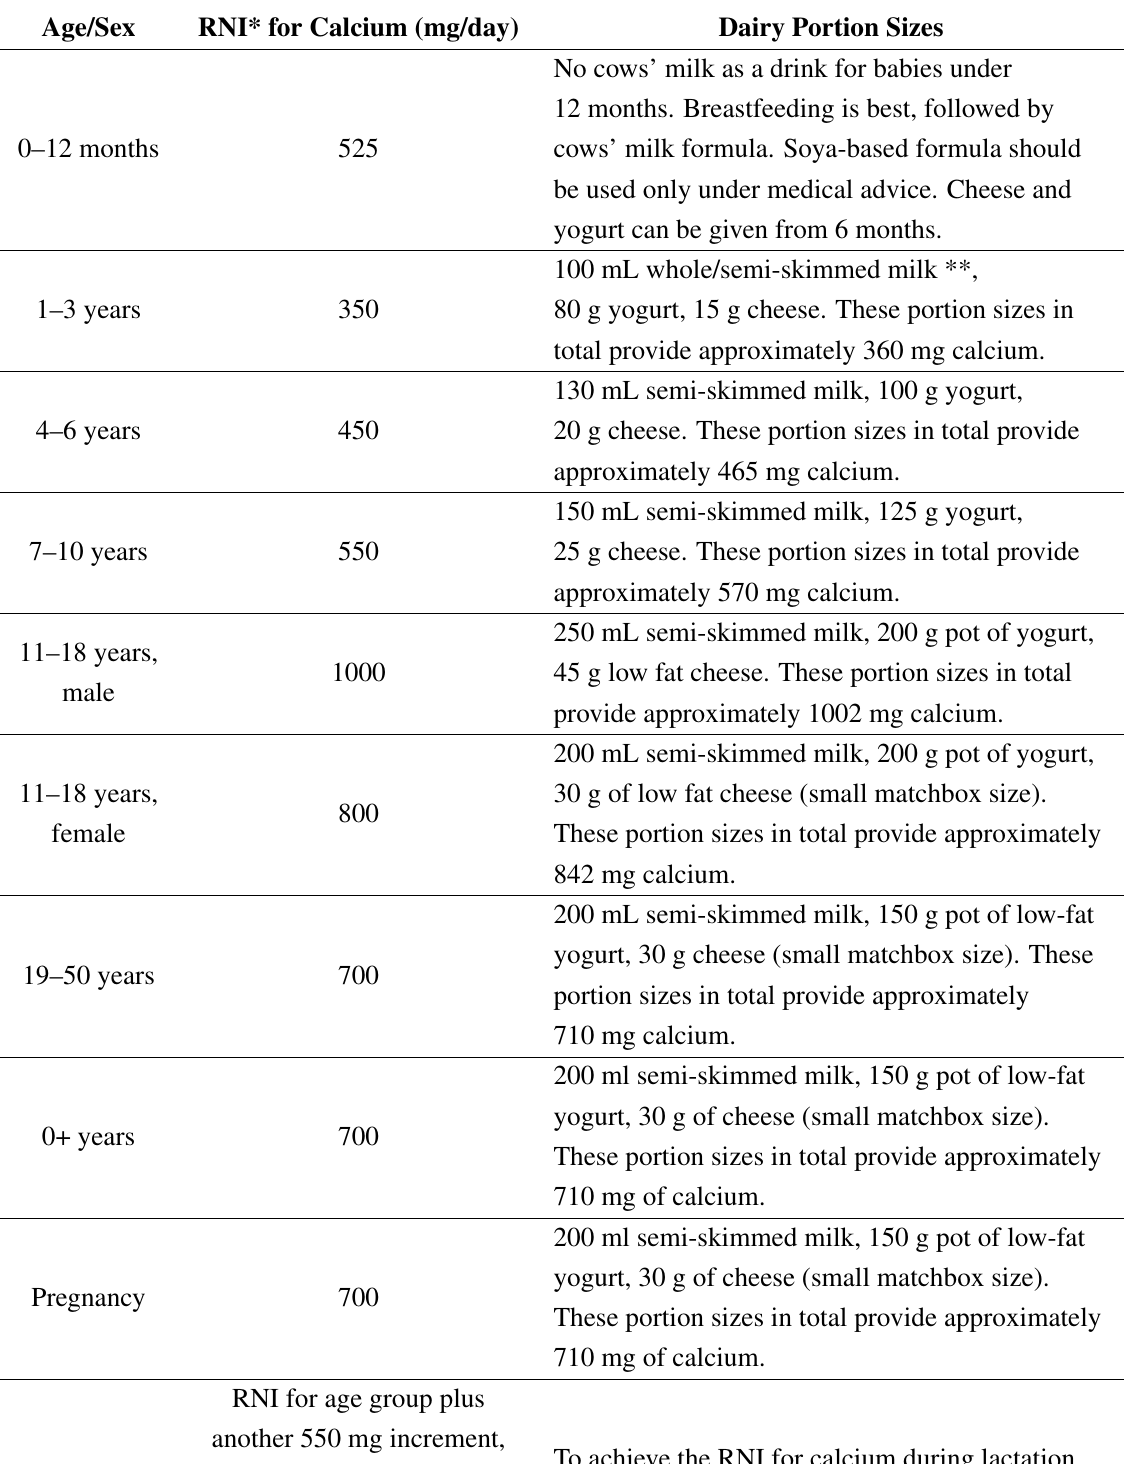
Table 10. Supply of calcium by a combination of milk and dairy products [85]. Age/Sex RNI* for Calcium